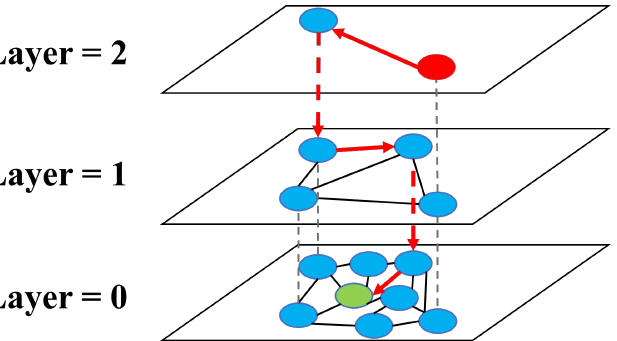
Figure 1. Illustration of HNSW. Data points are vertices and the similarity between points are edges. The search starts from an element from the top layer (shown red point). Red arrows show direction of the searching algorithm from the entry point to the query point (shown green